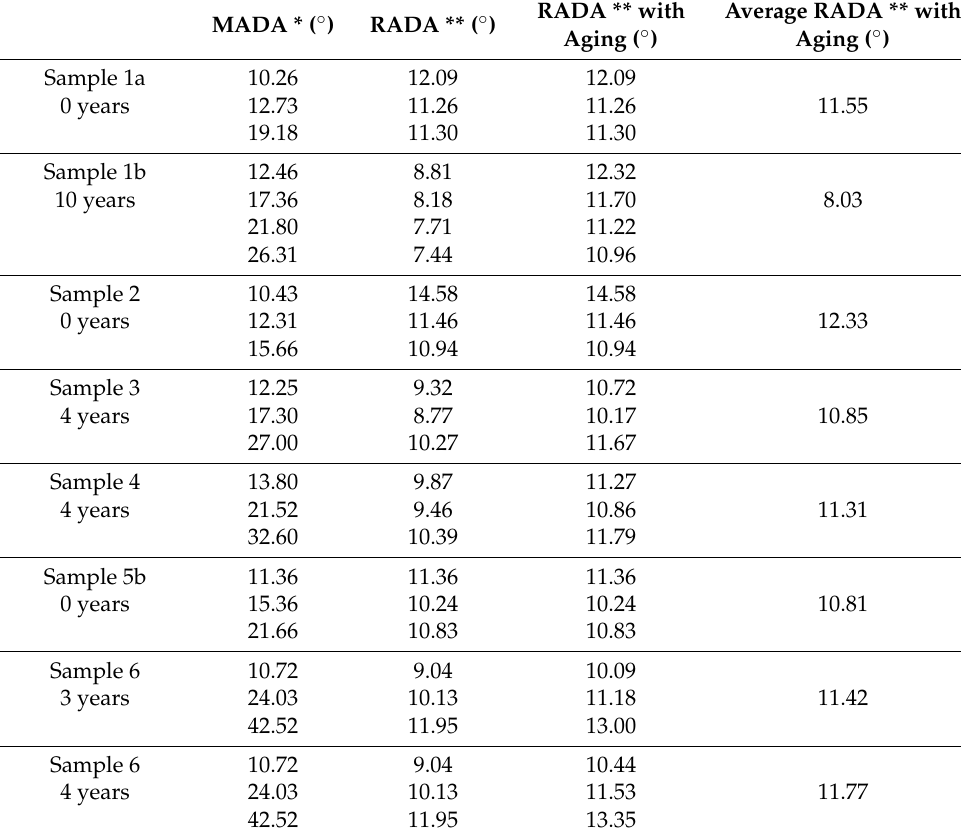
Table 5. Declination angles recalculated from measured average declination angles for individual samples to values corresponding to the thickness of 10 mm and traverse speed of 100 mm/min, also including correction for aging and average angle with